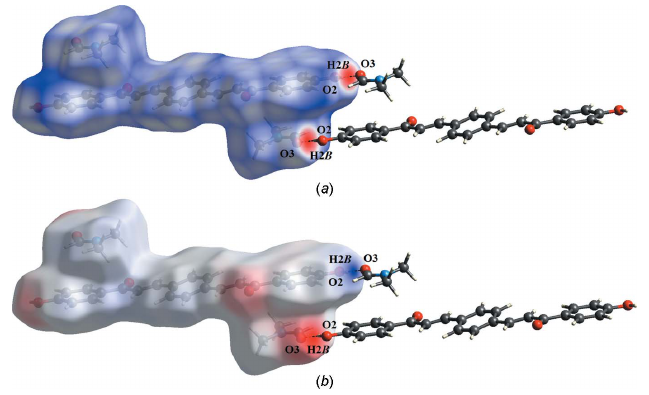
Figure 4 ( a ) d norm and ( b ) electrostatic potential mapped on Hirshfeld surfaces in order to visualize the intermolecular O—H (cid:2)(cid:2)(cid:2) O interactions in the title compound.